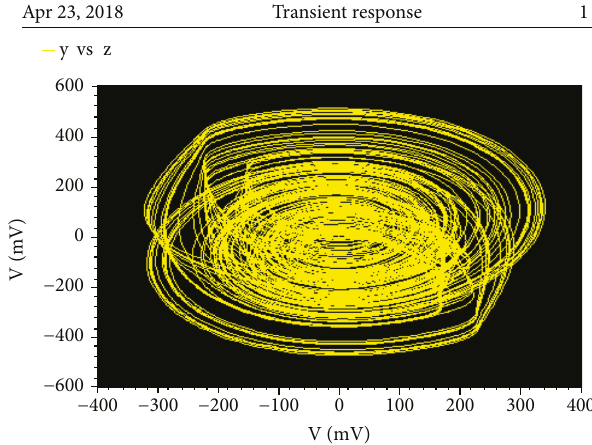
Figure 22: The phase portrait in the y - z plane (S turned